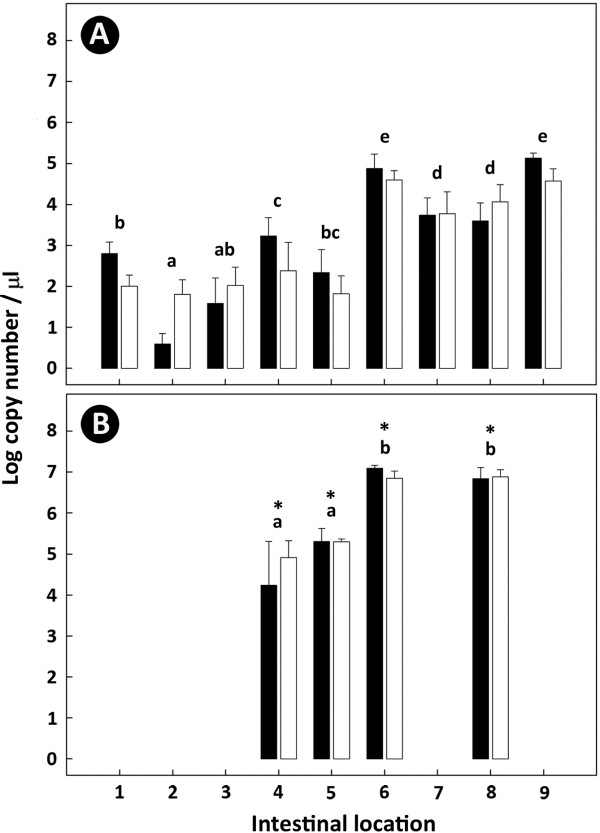
Relative bacterial densities throughout the intestine of beef cattle. Bacterial densities associated with mucosa (A) or within digesta were measured in the small and large intestine of beef cattle (log10 copy number μl-1 of template 16S rDNA). Treatments are cattle administered AS700 (black histograms) and cattle not administered antimicrobials (white histograms). Intestinal locations are: (1) duodenum; (2) proximal jejunum; (3) central jejunum; (4) distal jejunum; (5) ileum; (6) cecum; (7) spiral colon; (8) descending colon; and (9) rectum. Vertical lines associated with histograms indicate the standard error of the mean. Within A and B, histogram bars at each location not followed by the same letter differ (P < 0.05). Bars indicated by an asterisk differ (P < 0.001) between digesta and mucosa-associated at corresponding locations.